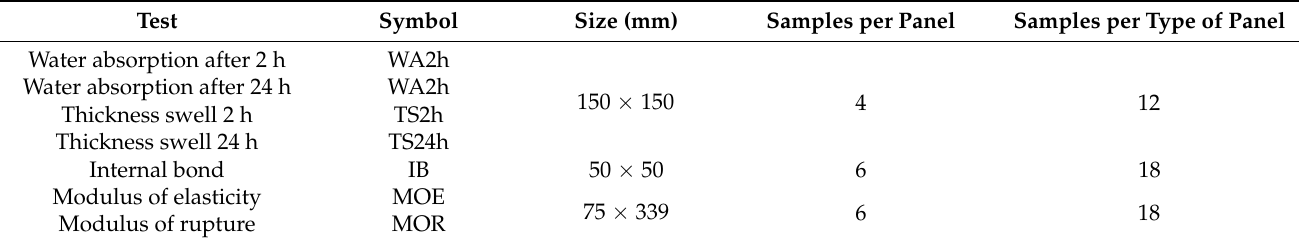
Table 3. Tests and samples sizes and number. The samples used for WA2h, WA24h, TS2h, and TS24h tests were the